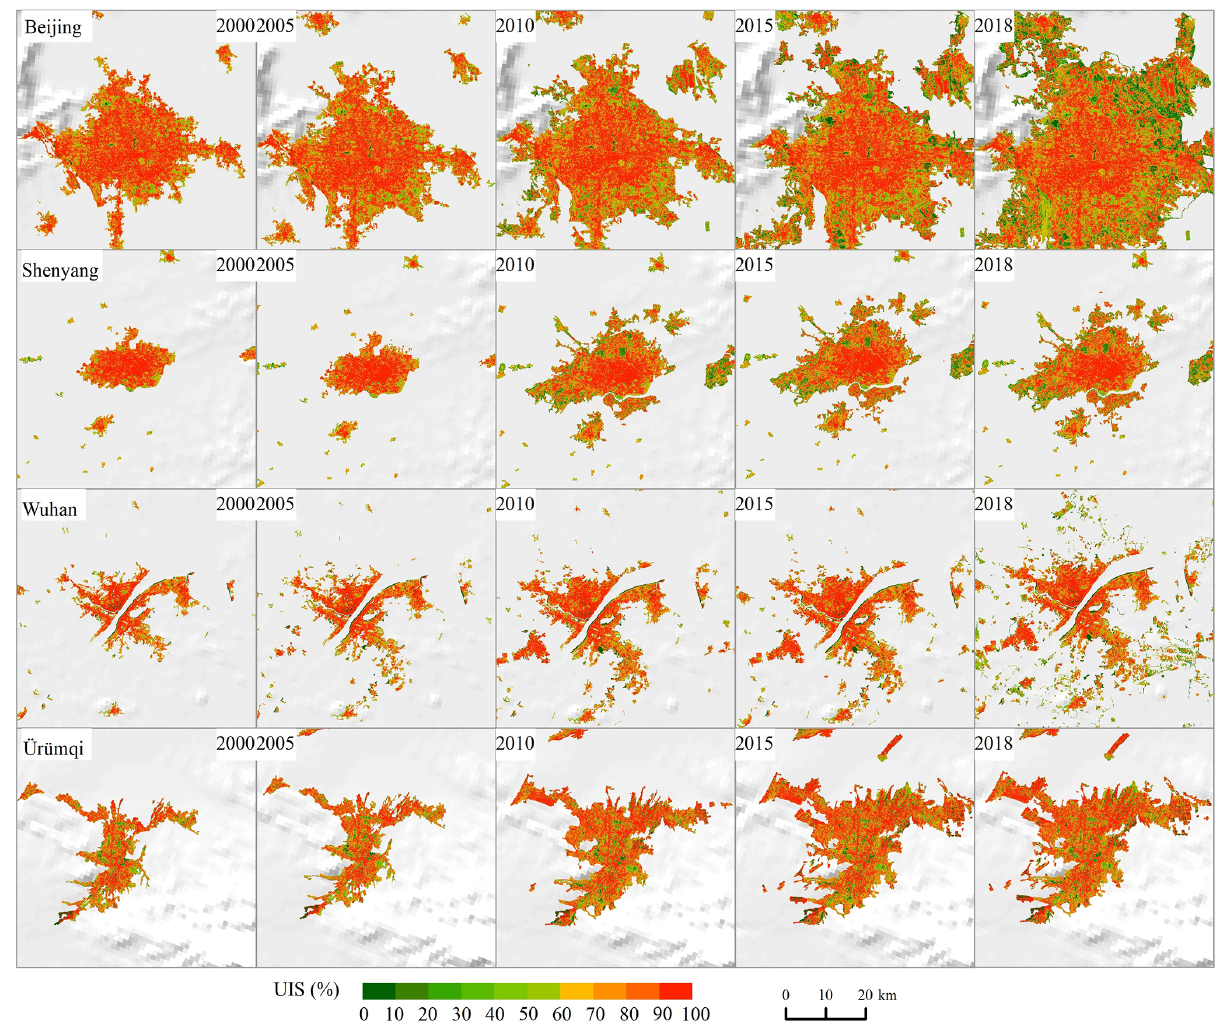
Figure 9. The spatial distribution of urban impervious surface (UIS) in selected cities from 2000 to 2018. DEM dataset was downloaded from SRTM 90m digital elevation data (http://srtm.csi.cgiar.org/, last access: 15 September